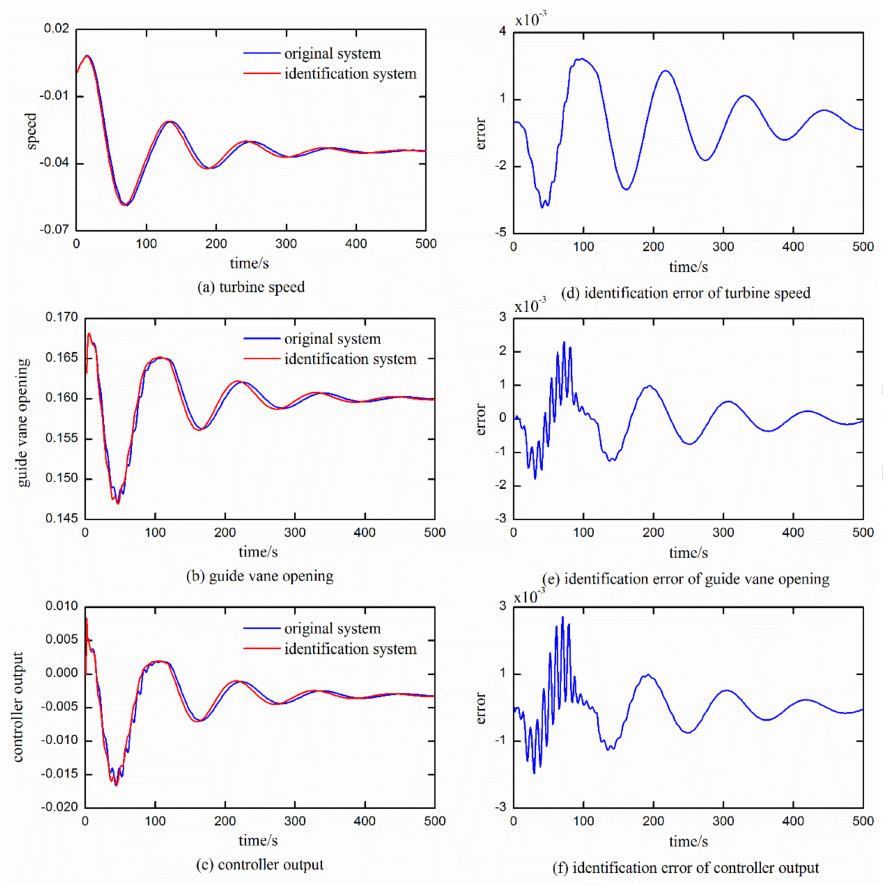
Figure 8. Comparison between the outputs of the three parts of the original and the identification systems under load disturbance: ( a ) outputs of the turbine speed; ( b ) outputs of the guide vane opening; ( c ) outputs of the controller output; ( d ) identification error of the turbine speed; ( e ) identification error of the guide vane opening; and ( f ) identification error of the controller